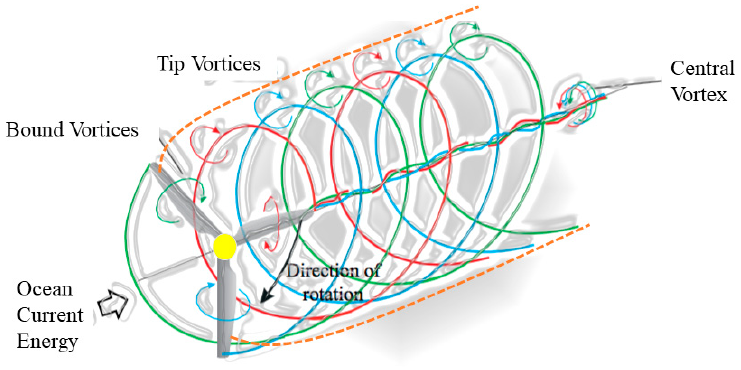
Figure 2. Schematic diagram of vortex system downstream of an ocean current turbine